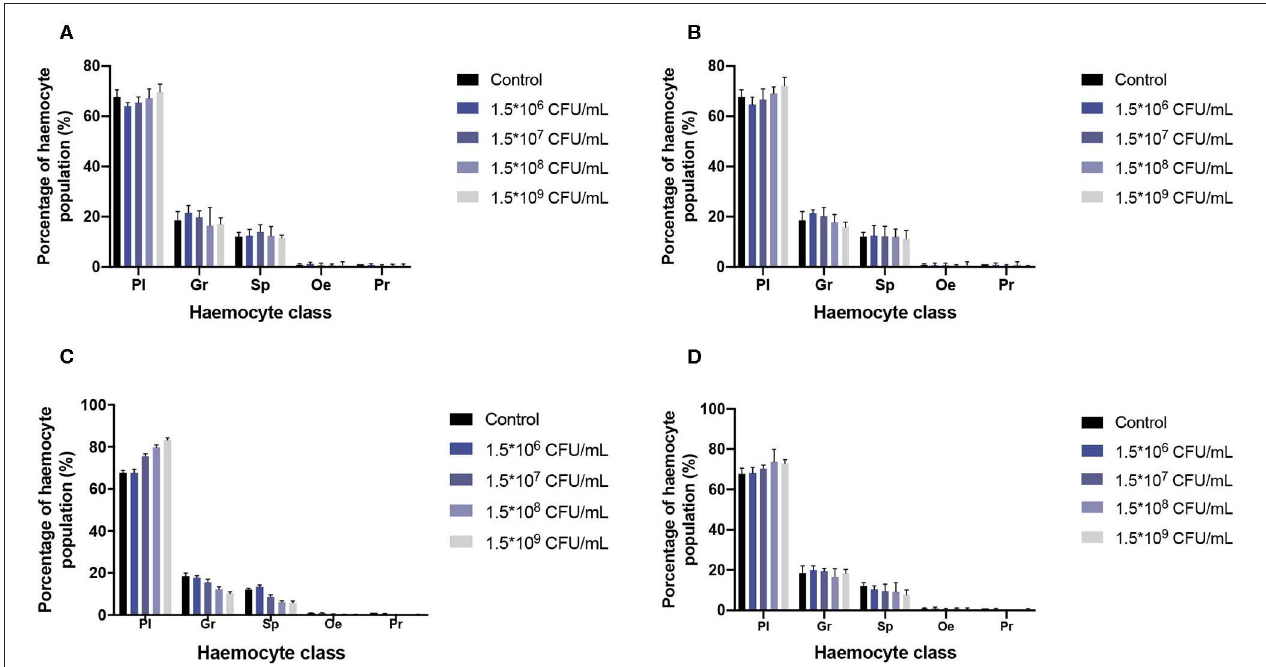
FIGURE 5 | Percentage of hemocyte population. A significant difference was found in hemocyte populations when the interaction between hemocyte class and inoculum concentrations was analyzed ( p < 0.05, 2-way ANOVA test). As can be noted, plasmatocytes tend to increase as the inoculum concentracion increases; on the other hand, Granulocytes, spherulocytes, oenocytes, and prohemocytes tend to decrease as the inoculum concentracion increases. (A) Percentage of hemocytes population of G. mellonella larvae infected with M. furfur at 33 ◦ C; (B) percentage of hemocytes population of G. mellonella larvae infected with M. pachydermatis at 33 ◦ C; (C) percentage of hemocytes population of G. mellonella larvae infected with M. furfur at 37 ◦ C; and (D) percentage of hemocyte population of G. mellonella larvae infected with M. pachydermatis at 37 ◦ C. Pl, plasmatocytes; Gr, granulocyte; Sp, spherulocyte; Oe, oenocyte; and Pr, prohemocyte.